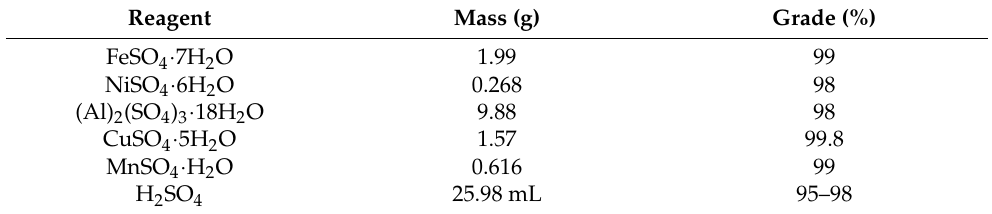
Table 1. Amount of reagents used for the preparation of synthetic acid mine drainage (AMD).